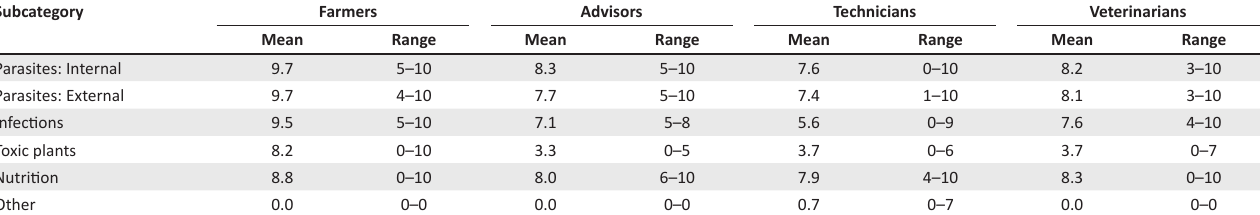
TABLE 5: Importance of livestock disease